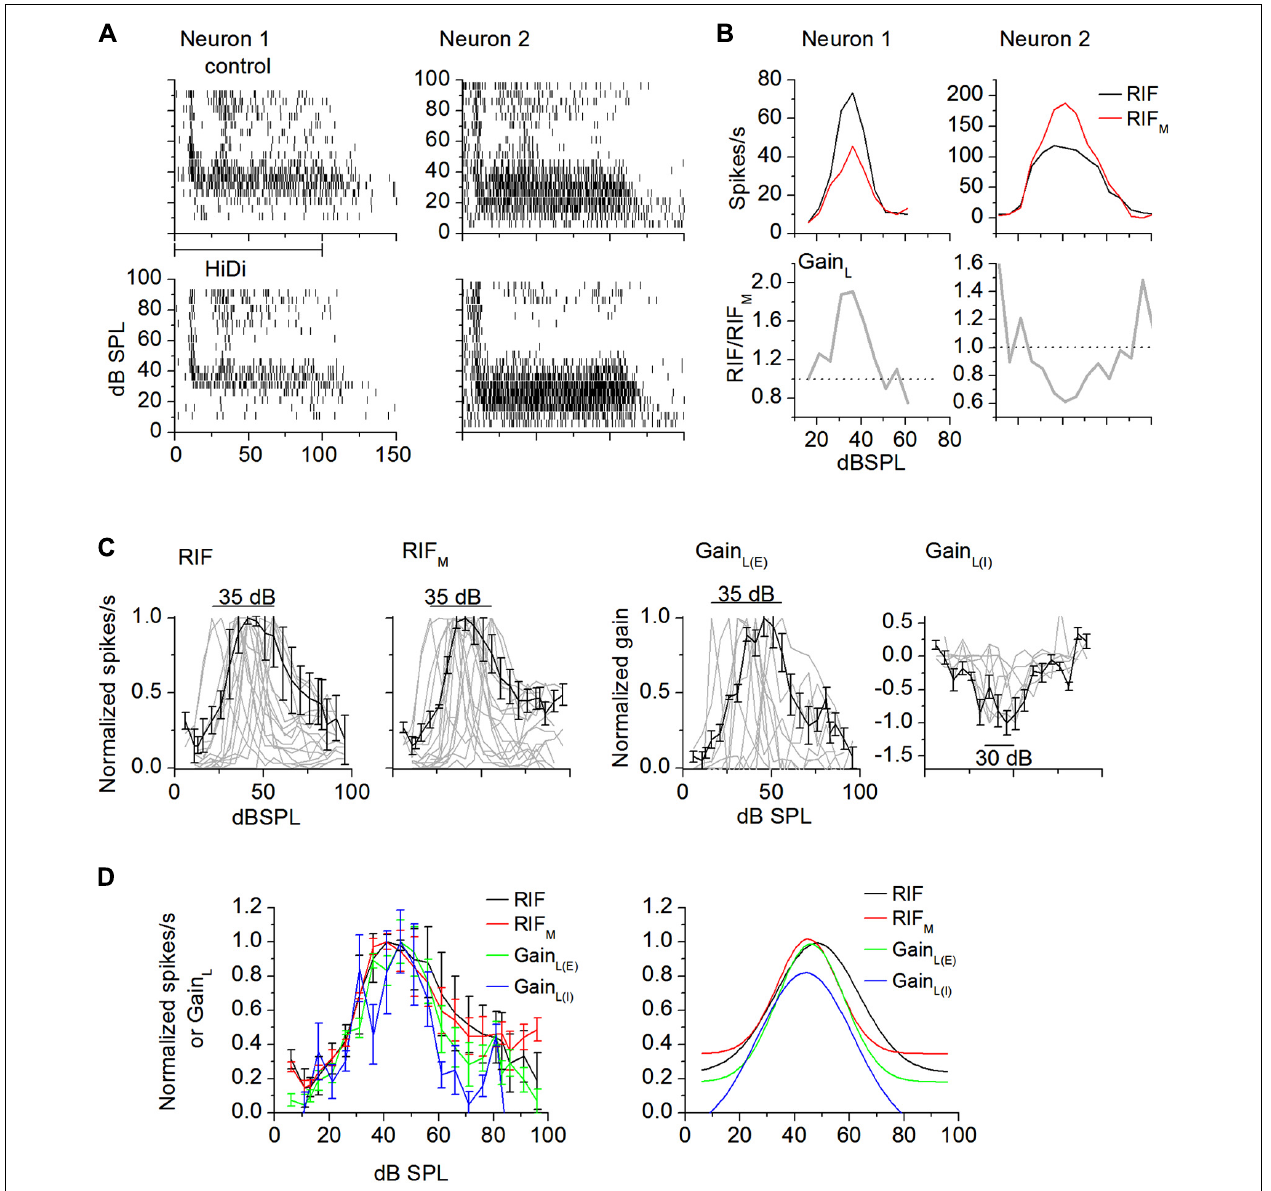
FIGURE 3 | External and local influences on intensity-tuning. (A) Spike rasters of two intensity-tuned neurons (neuron 1, neuron 2) in control and HiDi. HiDi decreases peak firing rate in neuron 1 and increases it in neuron 2. (B) RIFs for each of the neurons in (A) . Neuron 1: RIF M and Gain L are both excitatory.Top: RIF M is tuned to the same range of intensities as the output RIF. Bottom: Gain L , the ratio RIF/RIF M , is also tuned to the same intensities as the output RIF. In this neuron, the local circuit supplies a gain of 1.9 at peak tuned intensities. Dotted line: gain of 1 implies no net effect of the